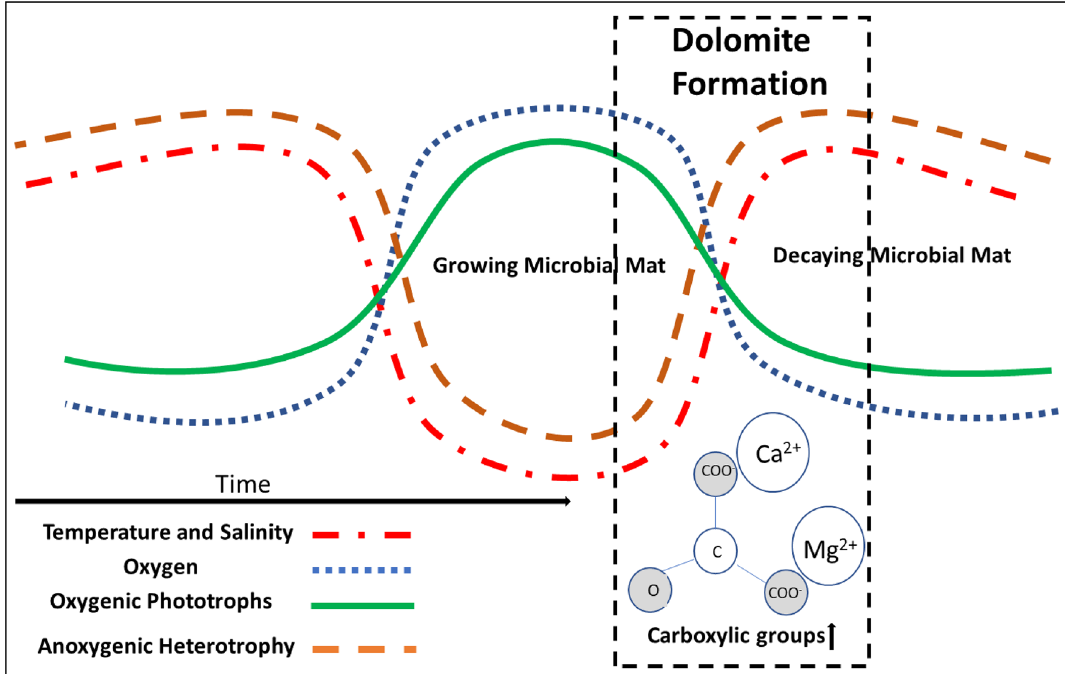
Figure 5. Conceptual diagram of proposed multi-seasonal low-t dolomite formation. Shifting environmental conditions cycle between higher and lower temperature and salinity. This results in the cycling of a growing and decaying microbial mat with low-t dolomite formation facilitated during the transition between growing and decaying